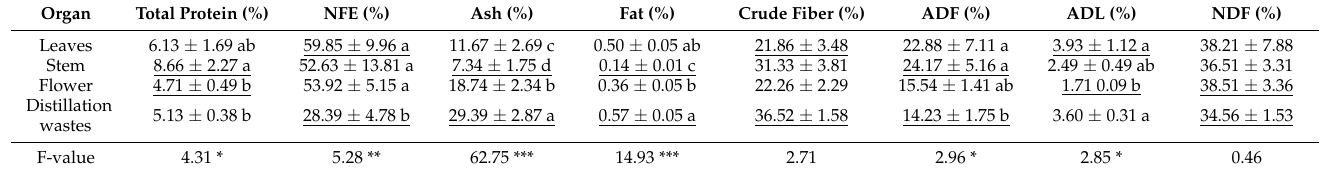
Table 3. Organic nutrient content (mean ± SD, n = 12) of the different organs of Taif’s rose grown on Al-Shafa highlands in Taif City, Saudi Arabia. Maximum and minimum values are